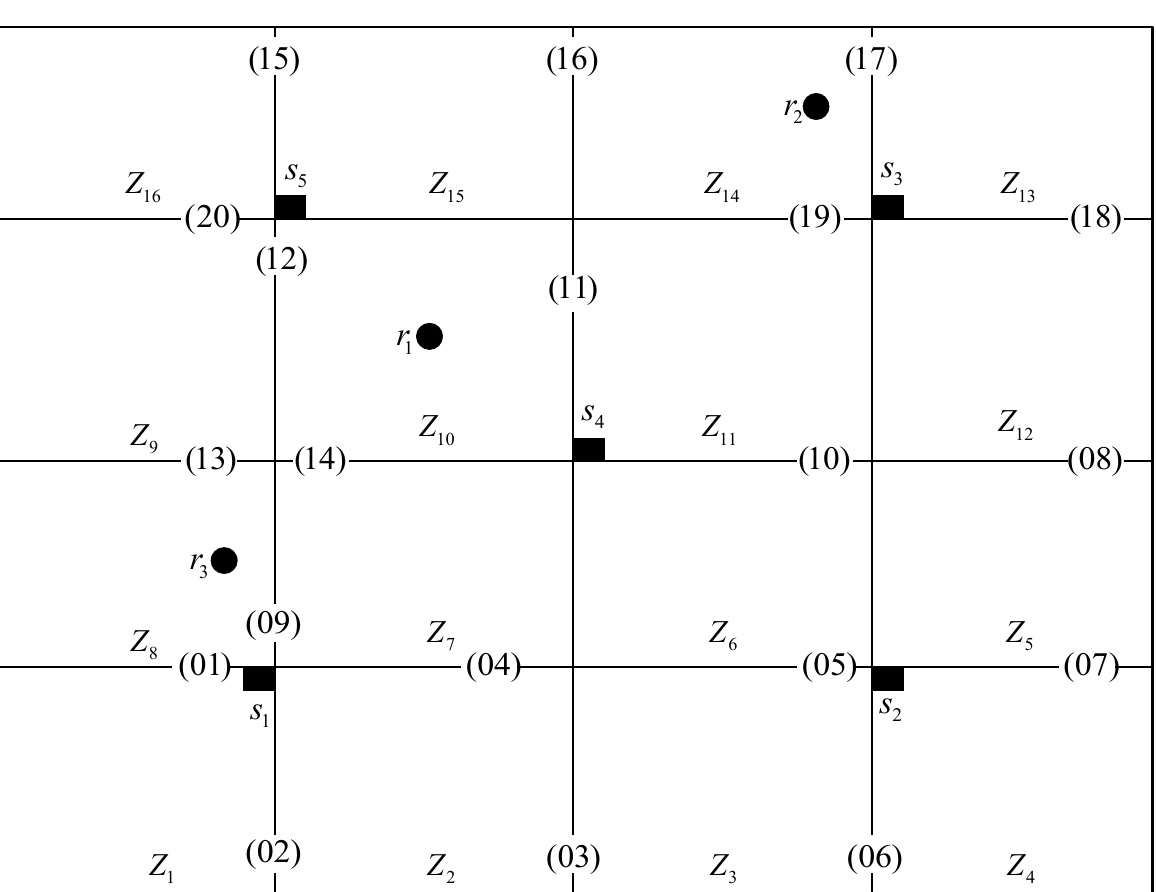
Service space of Simulation.